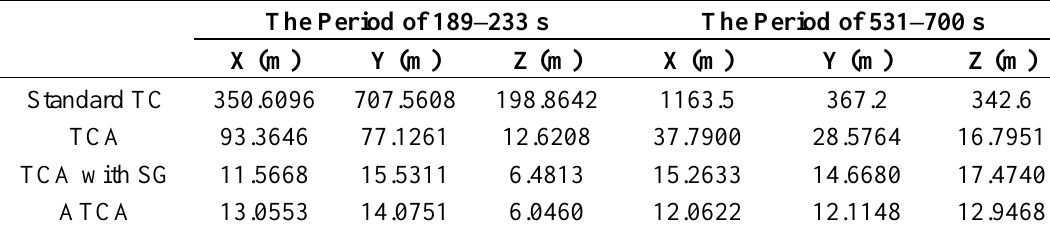
Figure 10. Position error comparisons: ( a ) position errors of TCA, TCA with SG and ATCA in the ECEF (Earth-Centered, Earth-Fixed) frame during the periods of 188 s and 233 s; ( b ) position errors of TCA, TCA with SG and ATCA in the ECEF frame during the periods of 531 s and 700 s. Table 3. RMS position error